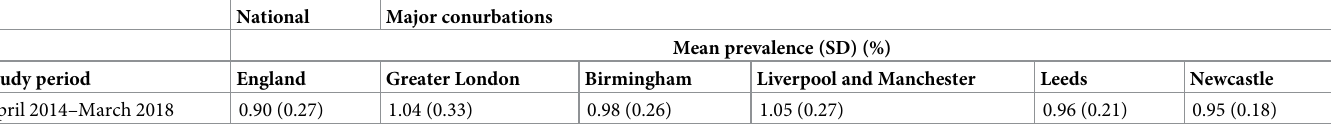
LSOA, Lower Layer Super Output Area; SD, standard deviation; SMI, serious mental